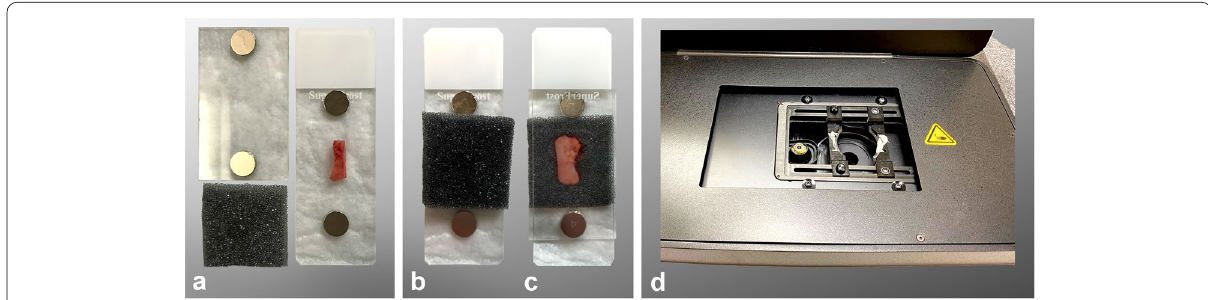
Fig. 1 Sample preparation for scanning, A Glass slide with tissue sample and sponge, B and C magnetic coverglass applies pressure to tissue sample on sponge, D Stage of the Vivascope